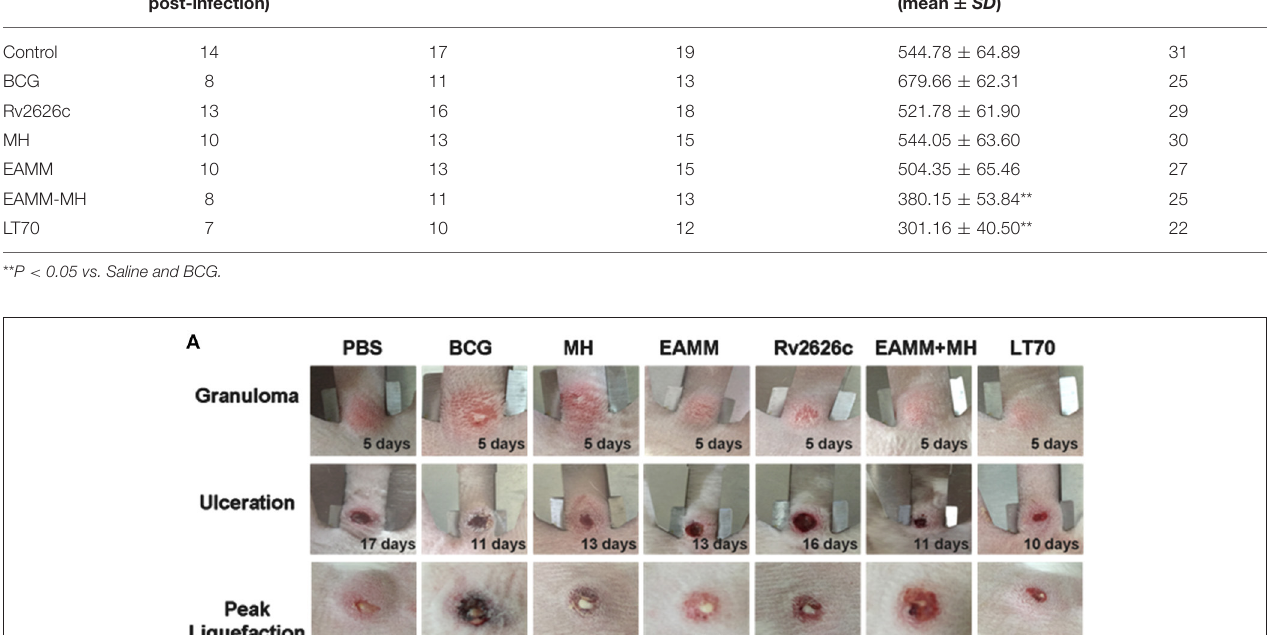
TABLE 1 | Effects of different vaccine candidates on BCG-induced rabbit skin lesions. Time of onset of Time of ulceration (days Time of peak of liquefaction liquefaction (days post-infection) (days post-infection) post-infection)